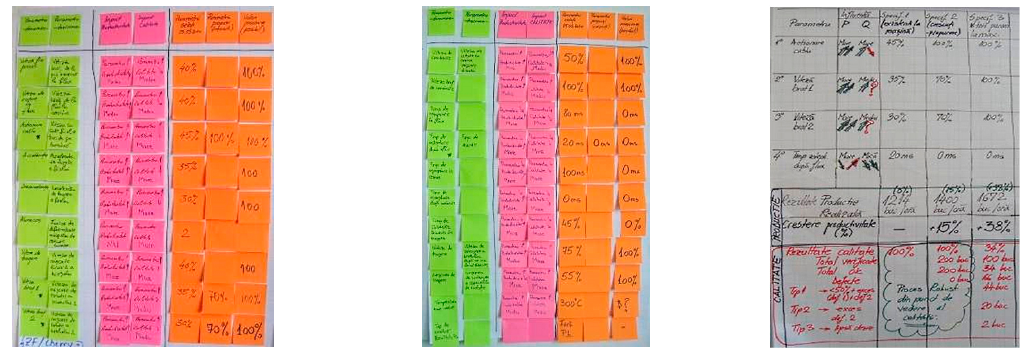
Figure 4. Analysis of parameters and their influence on quality and productivity.